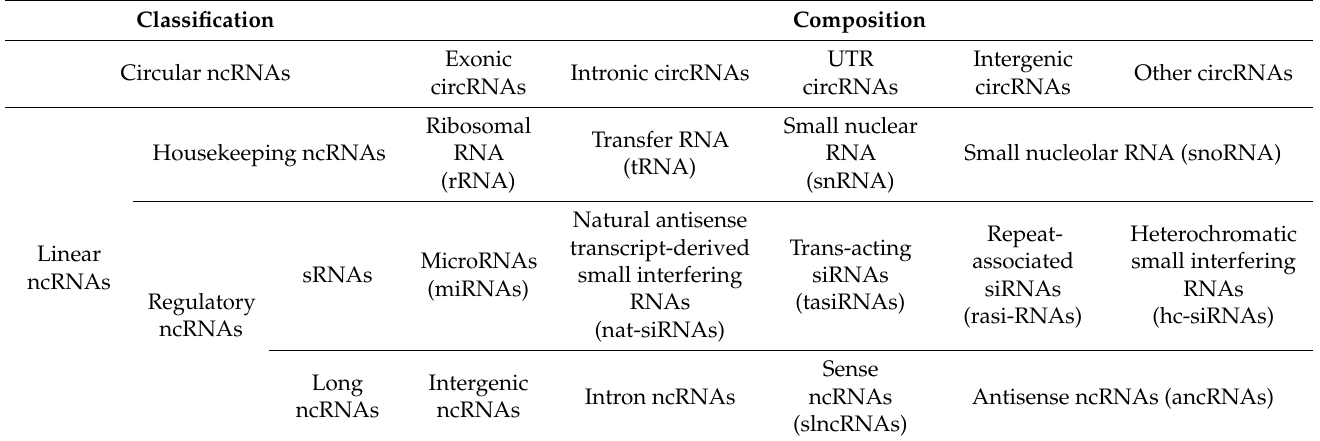
Table 1. Classification and composition of non-coding RNAs.